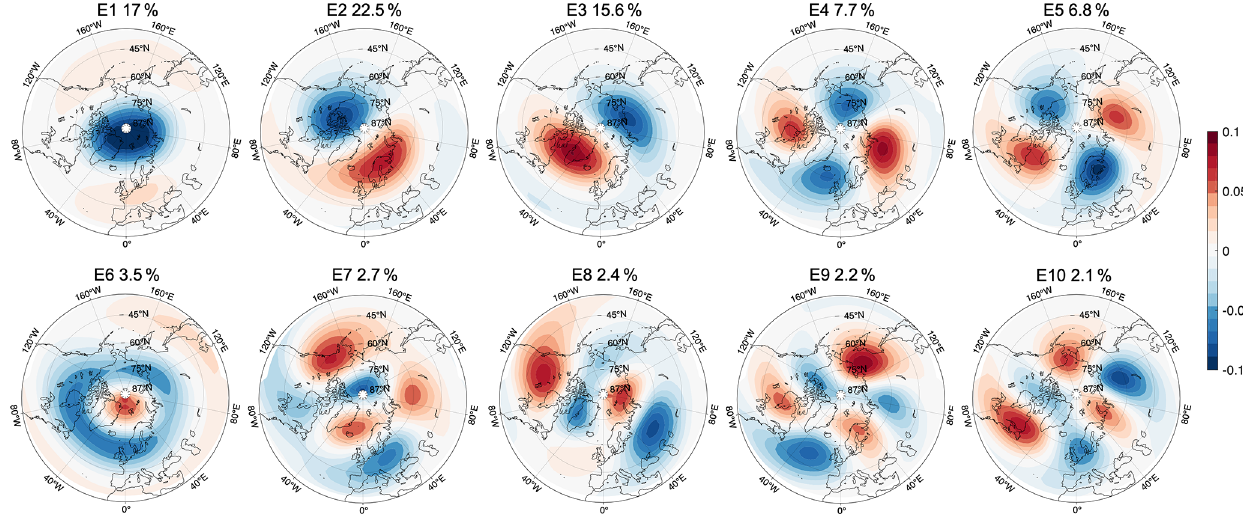
Figure C1. The first 10 EOF modes of PV at 850K ( E 1 , E 2 ,..., E 10 ) of the combined set of basis vectors as described in Sect. 2.1 using the simplified Isca model daily data. The percentage number indicates the variance explained by each EOF.